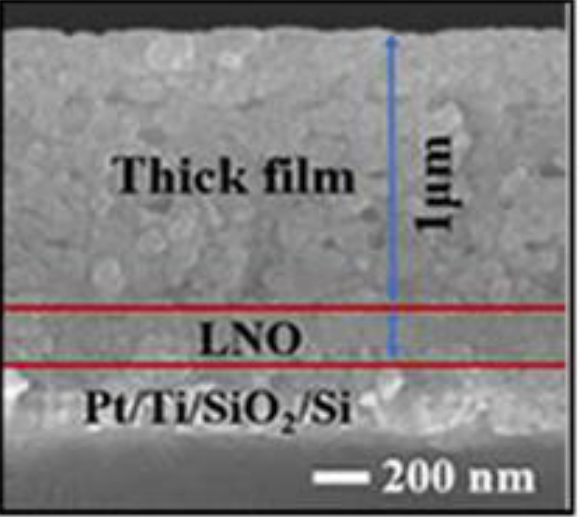
Figure 5. The cross-sectional SEM image of the 0.6(Na 0.5 Bi 0.5 )TiO 3 -0.4Bi(Ni 0.5 Zr 0.5 )O 3 thick films. The (110)-preferred LaNiO 3 (LNO) layer with a thickness of about 200 nm prepared on Pt(111)/TiO 2 /SiO 2 /Si substrates as bottom electrodes [62].